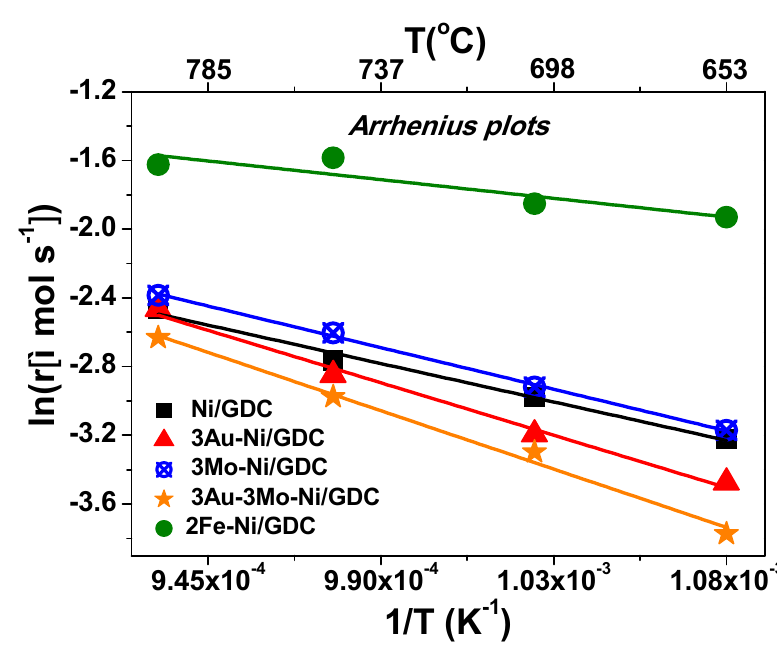
Figure 3. Arrhenius plots of the H 2 O re-oxidation rate (resulting from the slope of the isothermal TG profiles in Figure 2) for: Ni/GDC, 3wt% Au-Ni/GDC, 3wt% Mo-Ni/GDC, 3wt% Au–3wt% Mo-Ni/GDC, and 2wt% Fe-Ni/GDC Feed Conditions: 15.5 vol.% H 2 O/Ar, F total = 110 cm 3 /min (STP conditions: 0 °C, 1 atm).